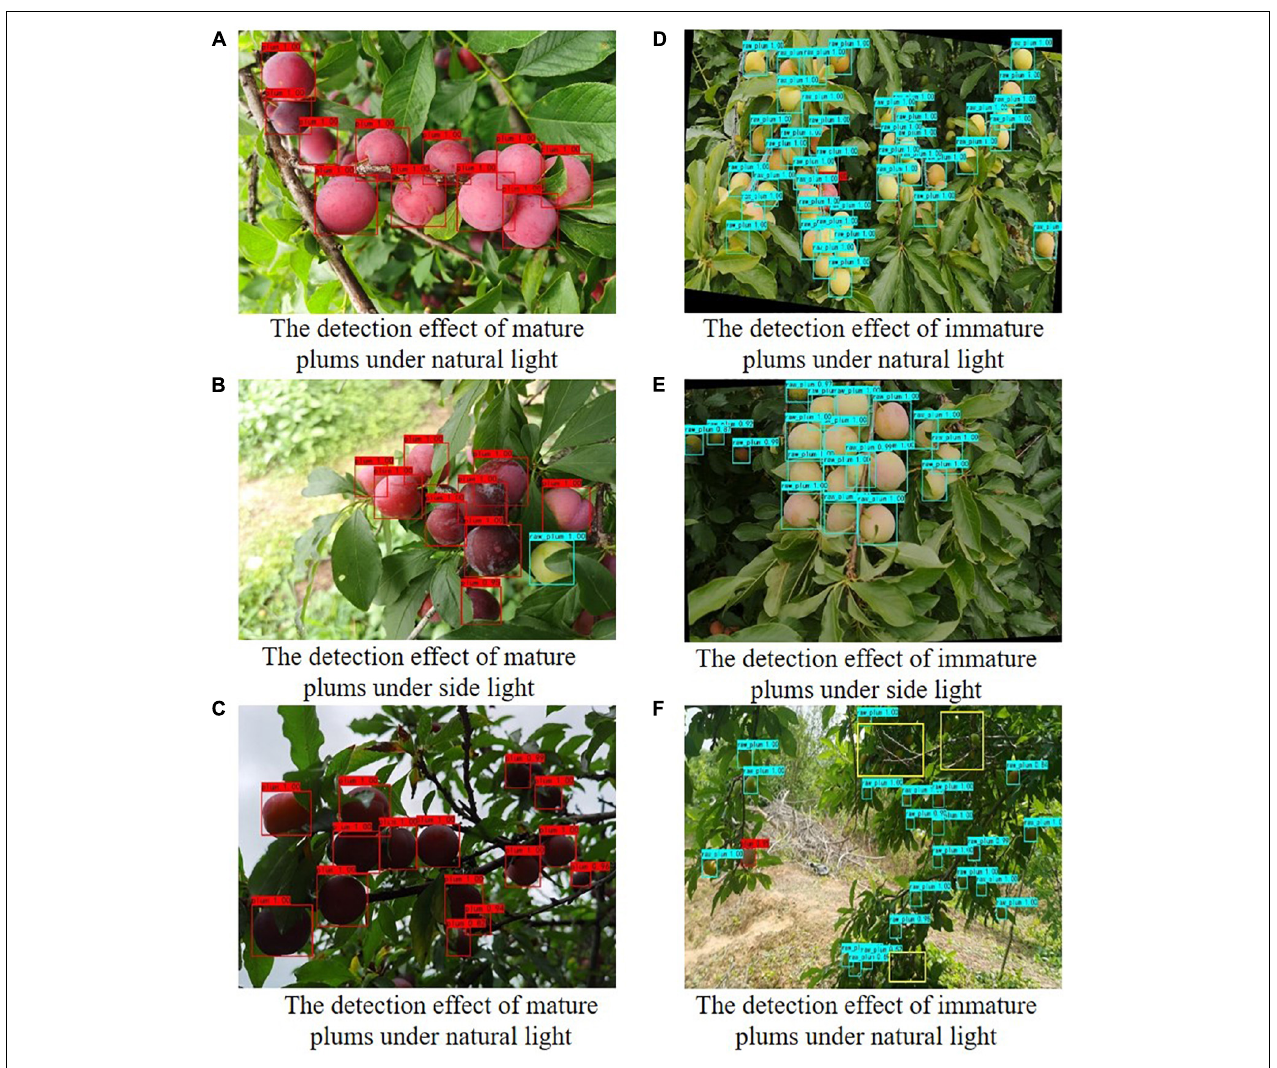
FIGURE 7 | Plum detection effect pictures under different light conditions.